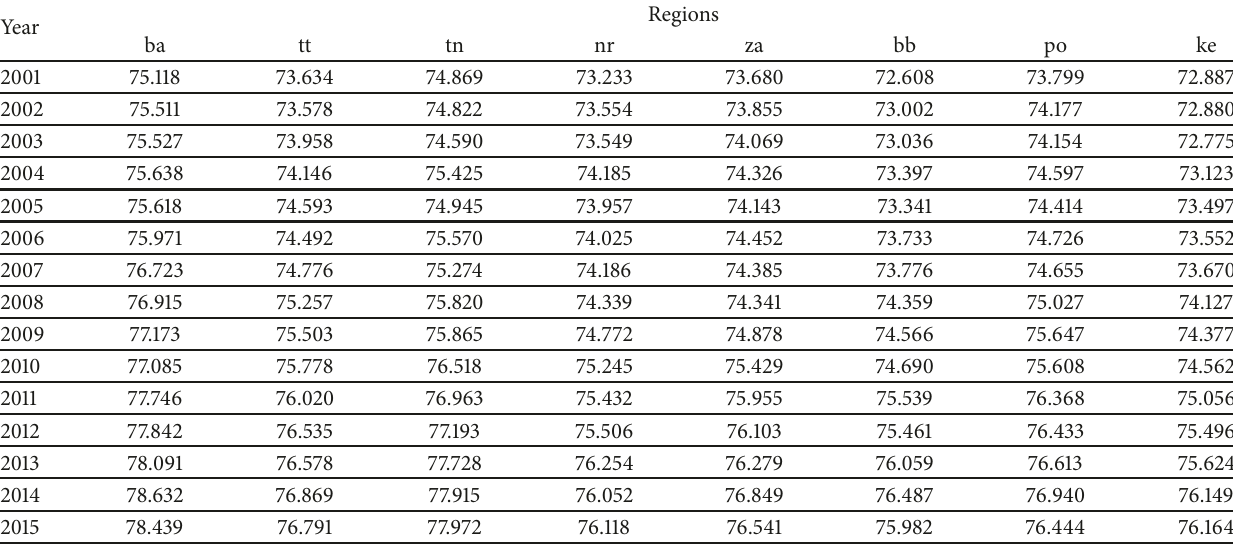
Table 2: Life expectancy (in years) at birth (age 0) by complete elimination of Alzheimer’s disease for Slovak regions.